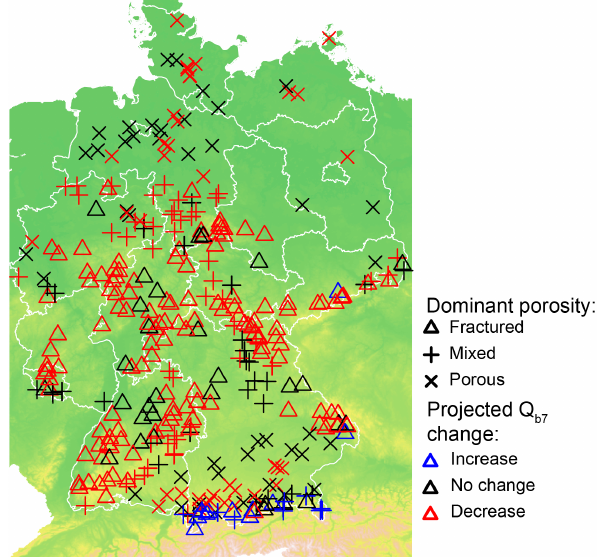
Figure 7. Future changes in Q b7 according to the test scenario.